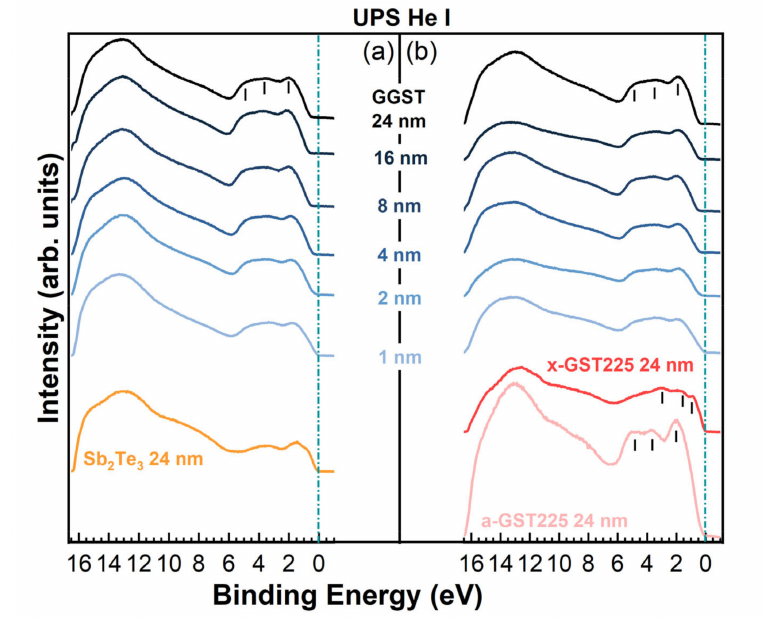
Figure 4. UPS spectra evolution measured for ( a ) sample A, ( b ) sample B as a function of the thickness of the deposited